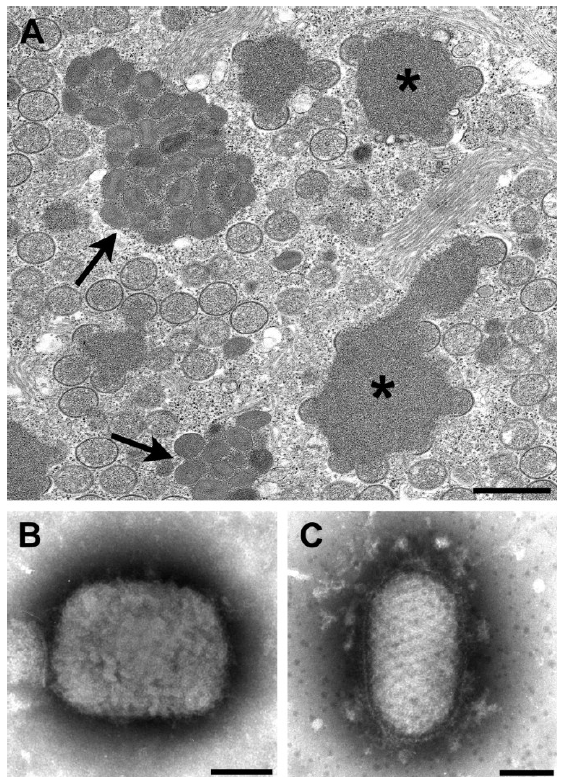
Figure 1. ( A ) Thin section image of raccoonpox, showing viral factories ( * ) and A-type inclusions (arrows). Bar, 500 nm; ( B ) Negative stain image of a clinical sample of monkeypox virus (genus Orthopoxvirus ). Bar, 100 nm; ( C ) Negative stain image of a clinical sample of orf virus (genus Parapoxvirus ). Bar, 100